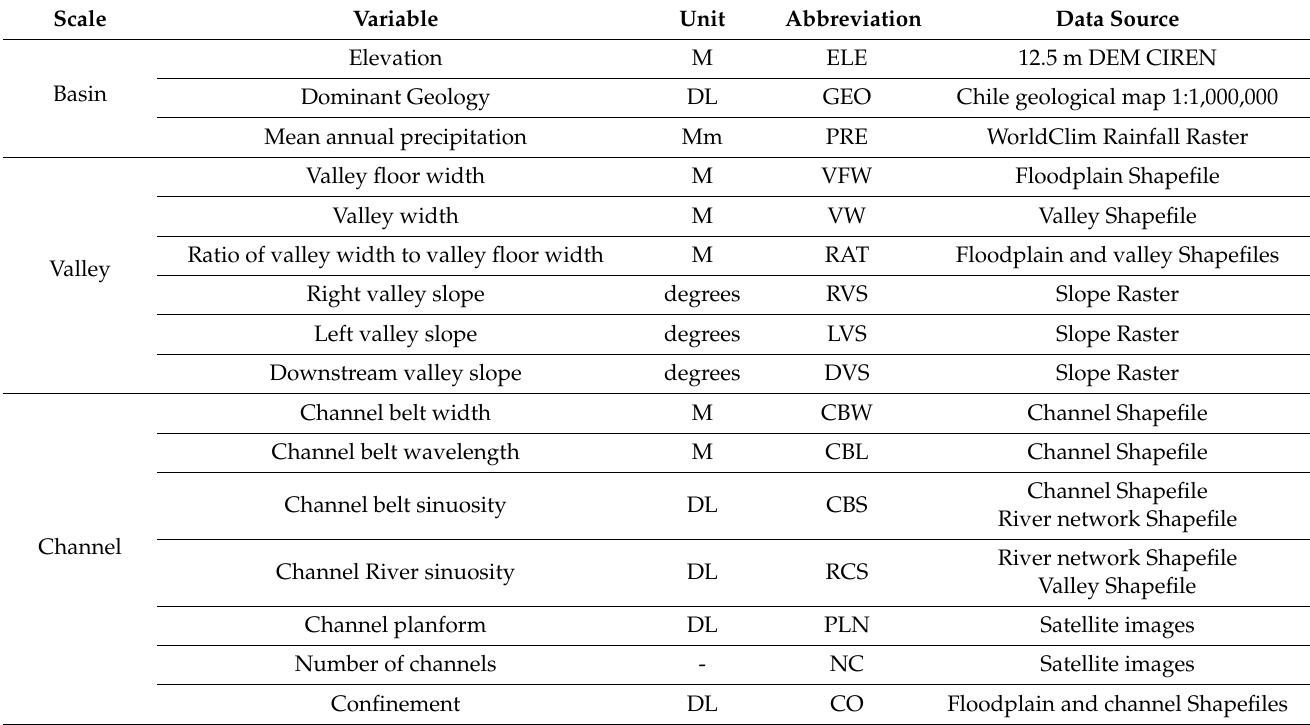
Table 2. Variables used for the determination of the Functional Process Zones. m: meters, mm: mil- limetres; DL: dimensionless; DEM: Digital Elevation